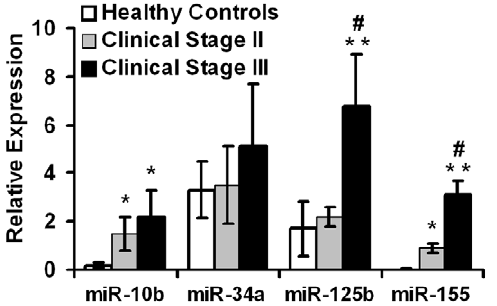
Figure 1. Levels of circulating miRNAs in breast cancer patients and healthy controls. Relative levels of circulating miR-10b, miR-34a, miR-125b and miR-155 were measured in healthy individuals (n=10) and clinical stage II patients (n=35) and stage III patients (n=21) by quantitative RT-PCR. Data represented mean 6 SD. * p , 0.05, ** p , 0.01 compared to healthy controls; # p , 0.05 compared to clinical stage II patients.